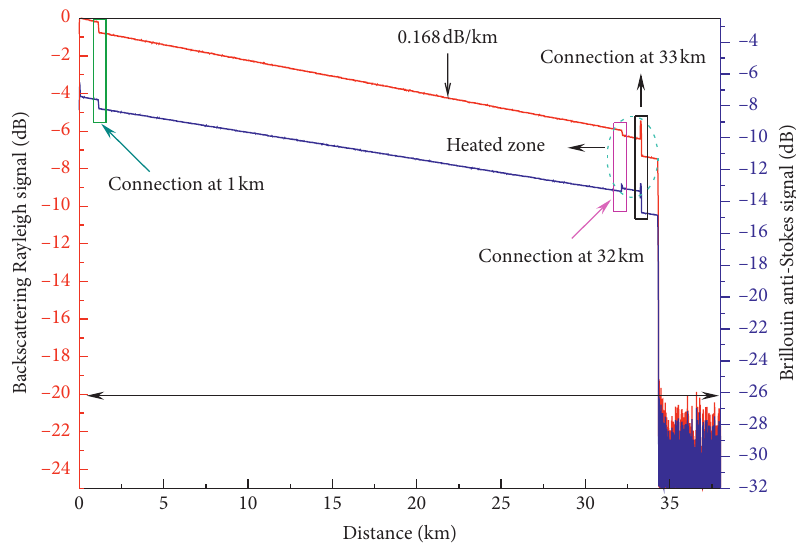
Figure 6: Measuring backscattered Rayleigh and anti-Stokes Brillouin signal traces under 1 μ s